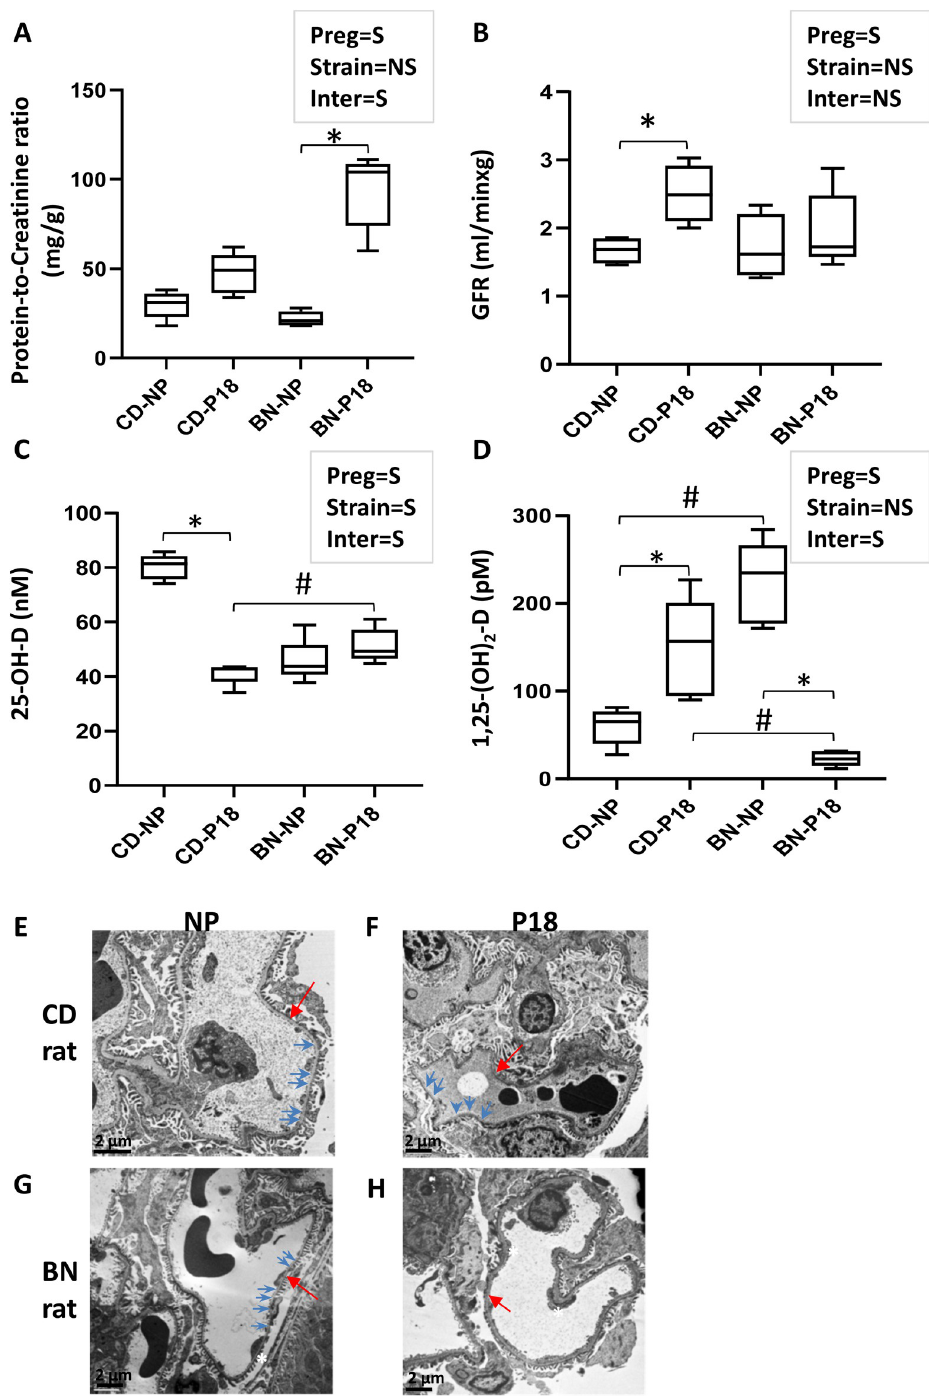
Fig 1. Renal functional and morphometric differences between BN and CD rats: A) Protein-to-Creatinine ratio (mg/ g) shows increased proteinuria in pregnant BN rats. B) glomerular filtration rate (GFR; ml/min x g) is increased in pregnant CD rats only. Maternal plasma levels of C) 25-OH-D, and D) 1,25-(OH) 2 -D as determined by ELISA. Bars represent the mean ± SE (n = 5/group). Text boxes show the 2-way ANOVA results for the effect of pregnancy (preg), rat strain (strain) or preg x strain interaction (inter) (S = significant, NS = non-significant). Composite 1-way ANOVA was performed to identify differences among the four groups: � p < 0.05 P18 vs NP. # p < 0.05 CD vs BN. E-H) Representative electron microscopy photos of glomeruli endothelial cells showed a normal thin basement membrane